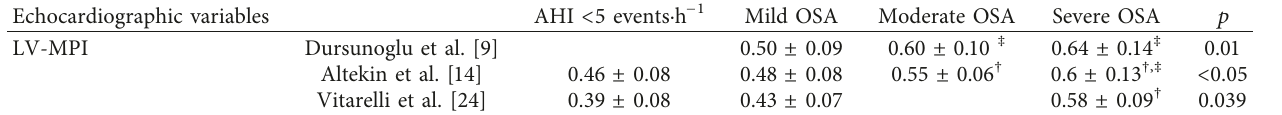
Table 5: Left ventricular myocardial performance index in relationship with OSA severity. Echocardiographic variables